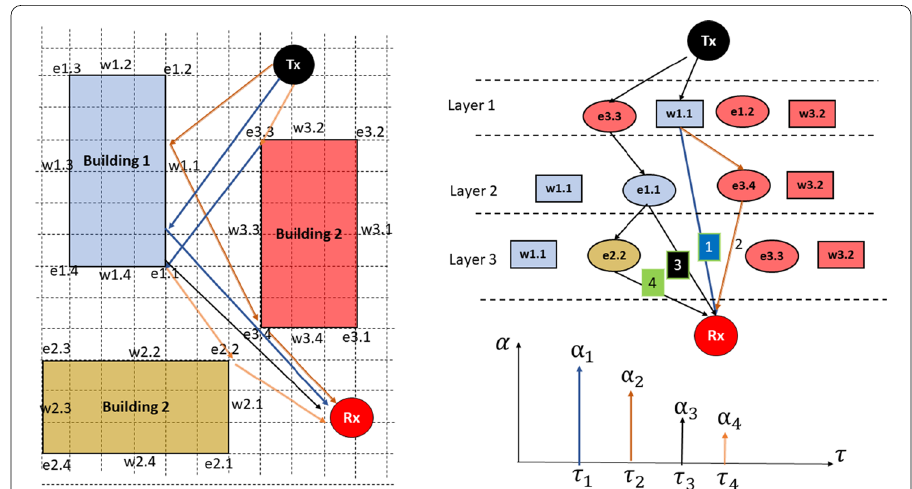
Fig. 4 Visibility tree from building walls and edges in ray tracing simulation, adapted from